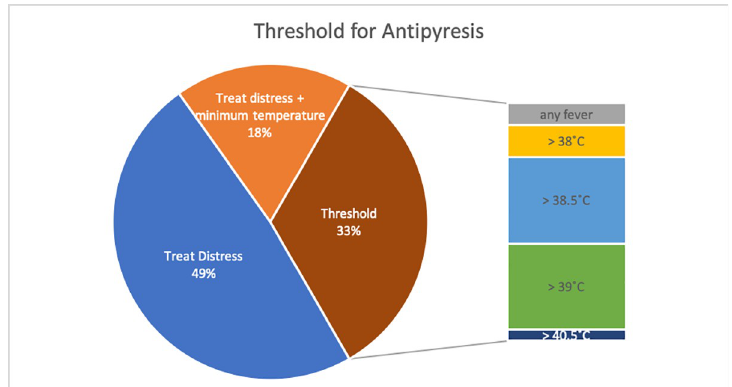
Fig 2. Threshold for antipyresis. Temperatures indicate the height of the given